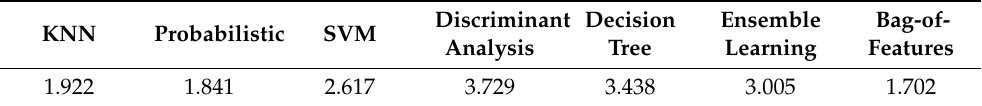
Figure 6. CDF plot for floor with 30 m × 30 m dimensions. Table 3. Mean absolute error of 30 m by 30 m floor.